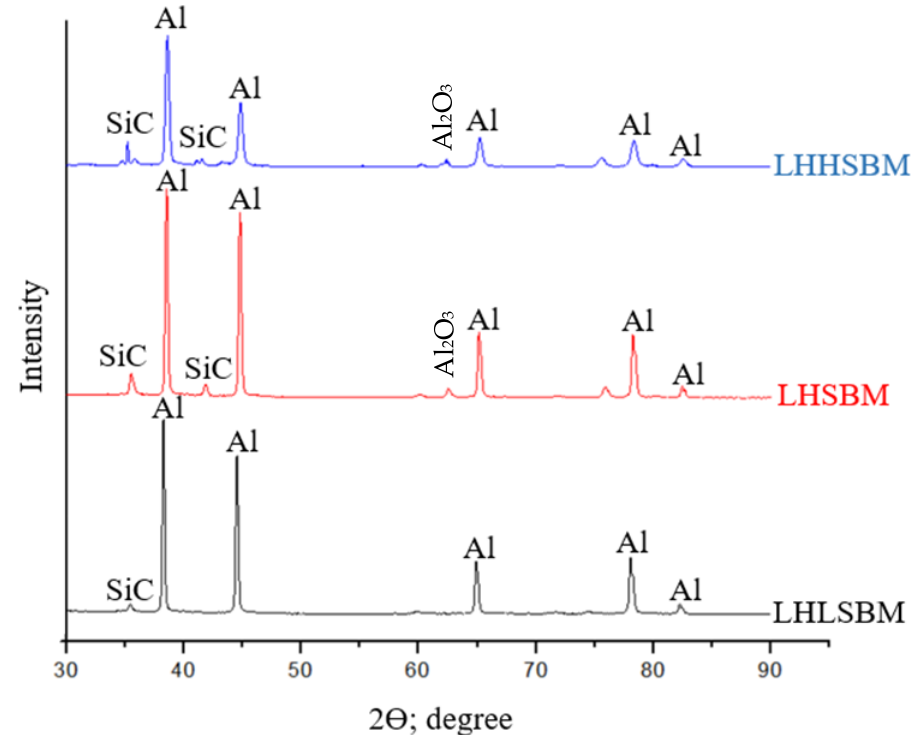
Figure 10. XRD of LHSBM, LHLSBM, and LHHSBM consolidated samples.